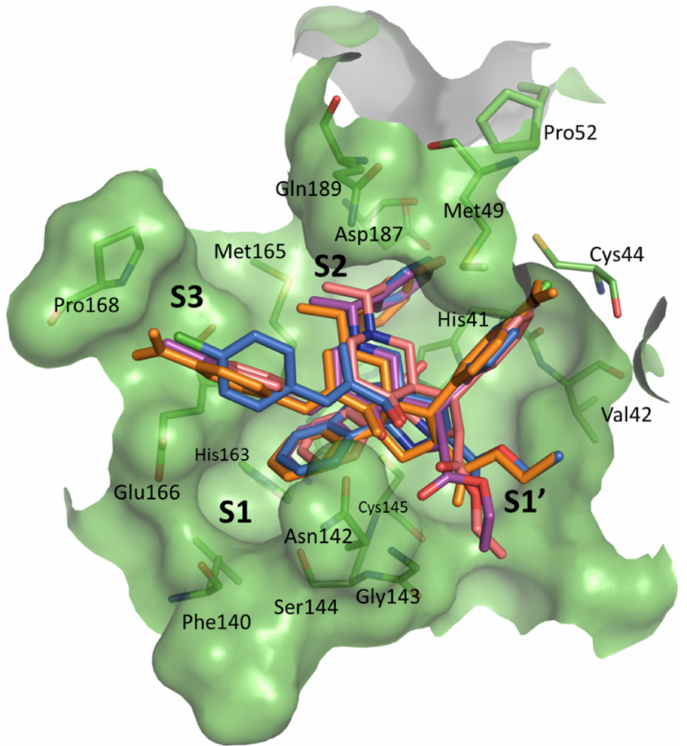
Figure 6. Graphical representation of the substrate-binding pocket of SARS-CoV-2 M pro [50] revealing S1 (cid:48) –S3 subsites. Overlay of the docked poses of compounds 4a (coral), 4b (magenta), 4d (blue) and 4e